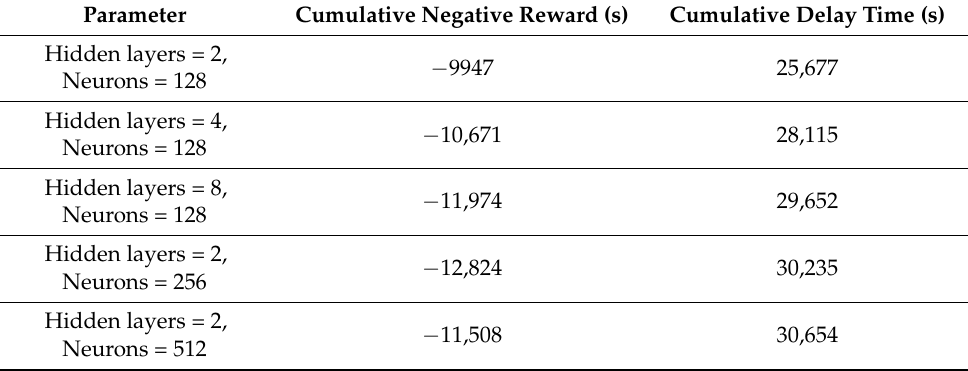
Table 2. Hyperparameters of DNN.